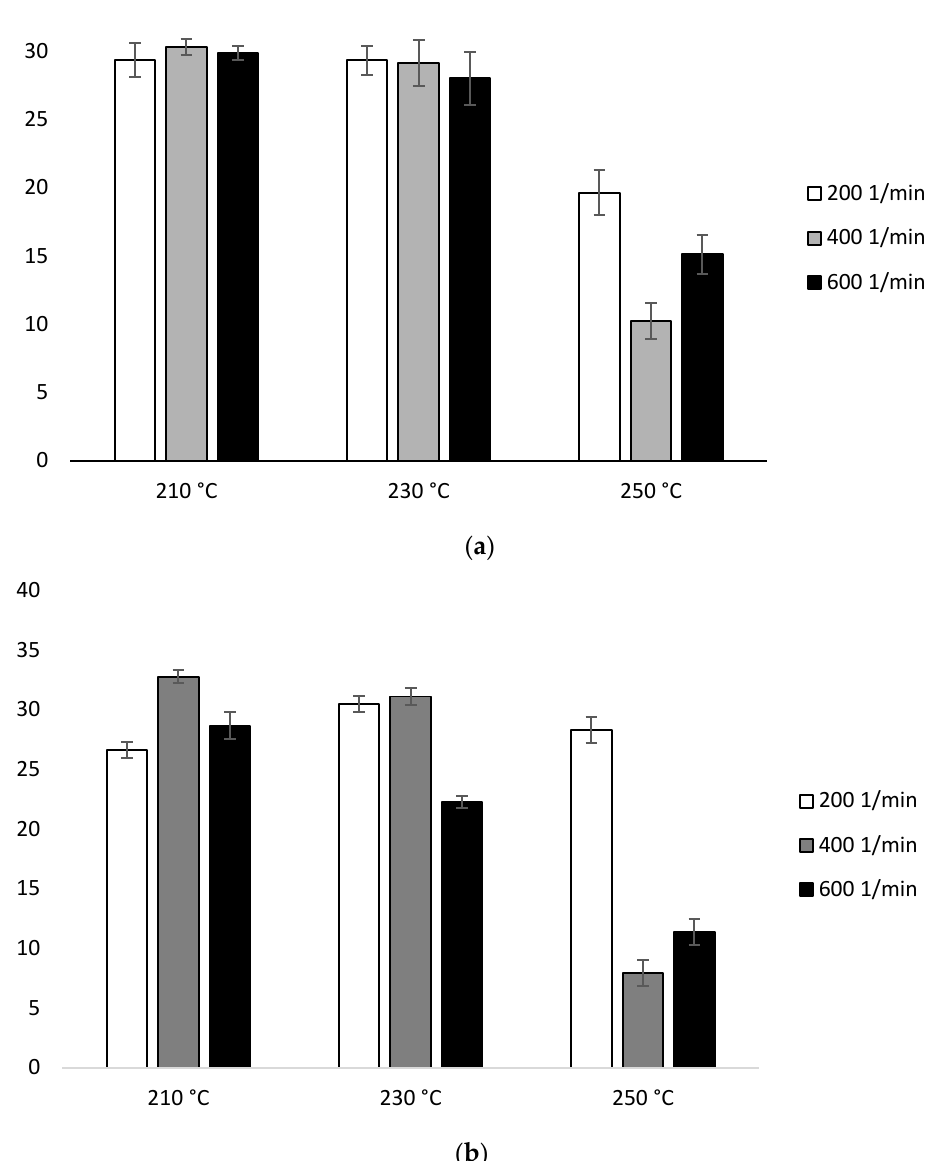
Figure 7. Enthalpy of cold crystallization ( Δ H cc ) of heating 1: ( a ) configuration 1; ( b ) configuration 2. Abbreviations: as in Table 1.